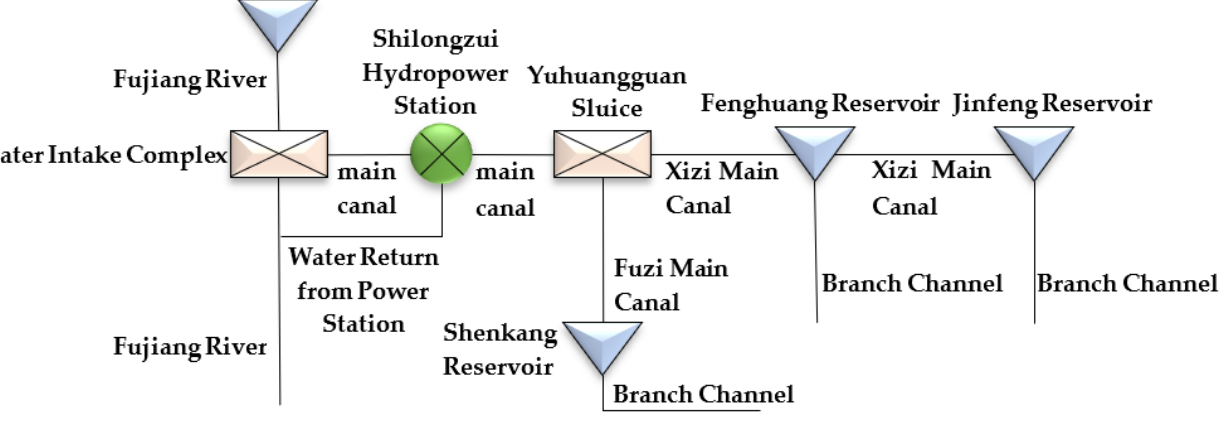
Figure 2. An overview of main canals and connections in the Wudu diversion and irrigation area.